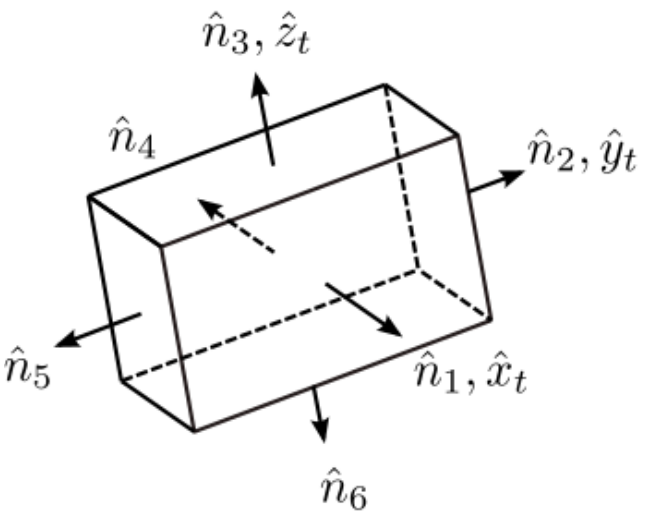
Figure 2. The six sides of the target are the limits preventing the chaser from colliding with the target. The attitude, body rates and docking port position of the target are assumed to be determined by a camera on the chaser, and the target should be within the chaser’s field of view. That is, the camera vector should always point to the target’s center of mass within a tolerance angle of